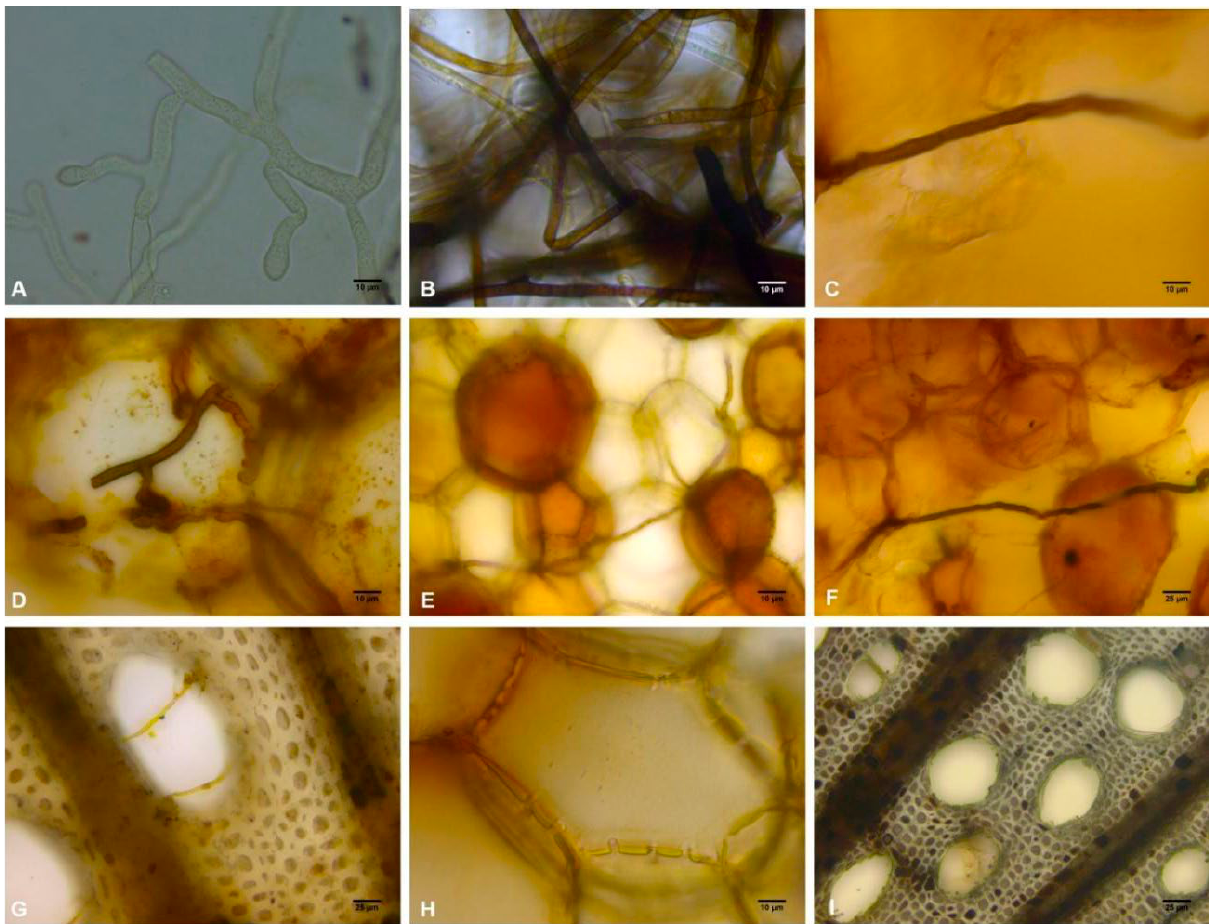
Figure 7. In planta melanin staining of Lasiodiplodia gilanensis using the Masson-Fontana method. A) Non-melanized fungus on PDA). B) Melanized fungus on PDA). C), D), E), and F) Melanized fungus colonizing the host plant piths. G) Fungus colonizing vascular bundles. H) plant pith in an uninfected plant. I) Vascular bundles in an uninfected